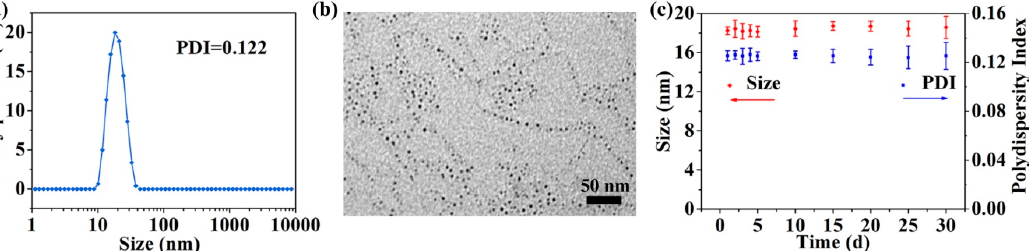
Figure 2. ( a ) The size distribution of AIE-M determined by dynamic light scattering (DLS) in water; ( b ) Transmission electron microscope (TEM) image of AIE-M after staining with 1% uranyl acetate; ( c ) Colloidal stability of AIE-M stored at 4 °C.